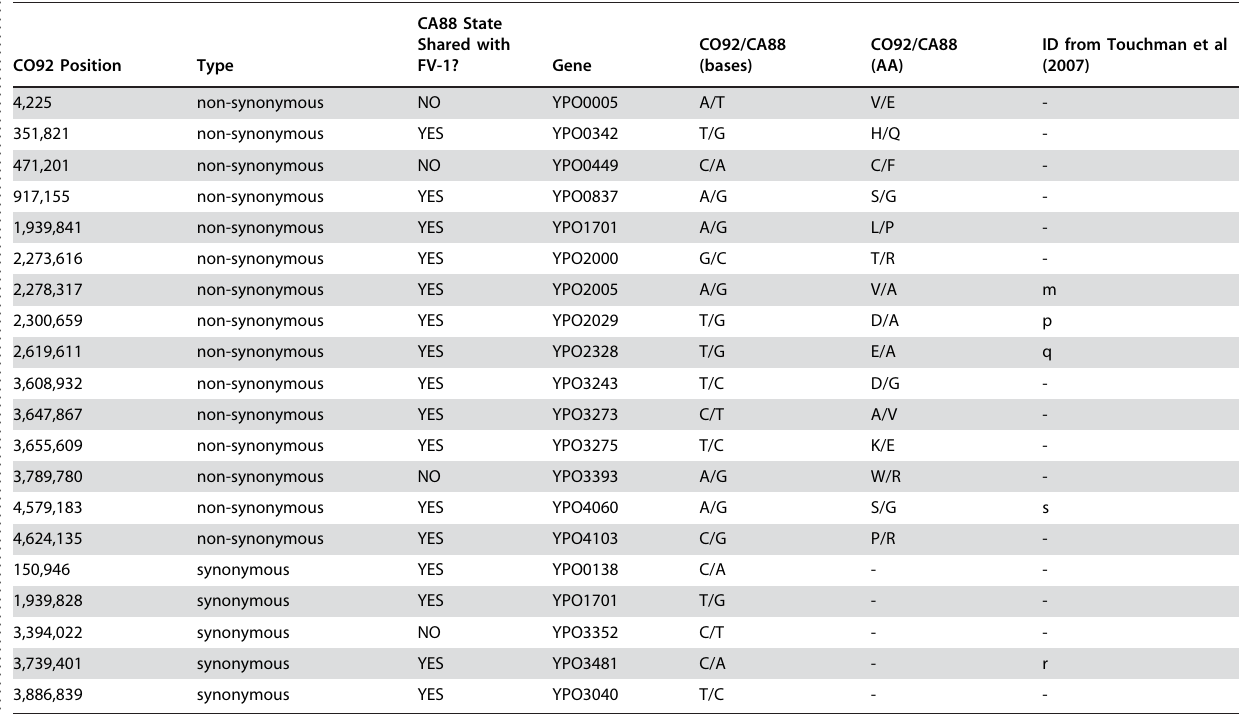
Table 6. Putative non-synonymous and synonymous SNPs found between CO92 and CA88. .. ... .... ... ... .... ... ... .... ... ... .... ... ... .... ... ... .... ... ... .... ... ... .... ... ... .... ... ... .... ... ... .... ... ... .... ... ... .... ... ... .... ... ... .